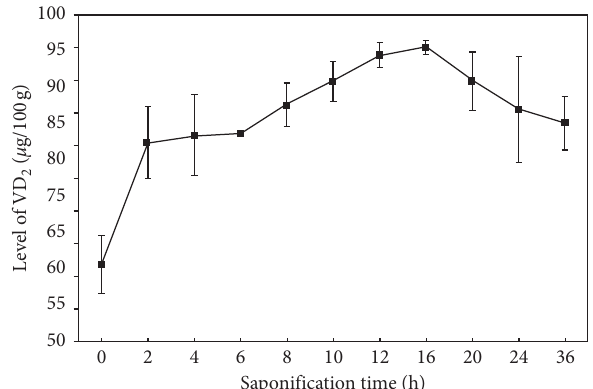
Figure 3: Separation of two-dimensional chromatogram of vitamins D VD 3 ).